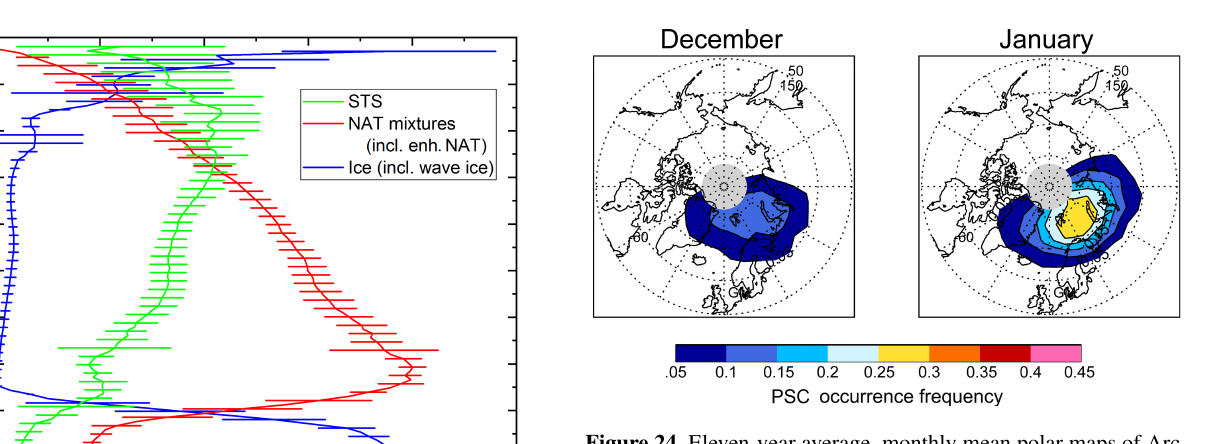
Figure 24. Eleven-year average, monthly mean polar maps of Arc- tic PSC occurrence frequency at θ = 500K ( ∼ 20km). Light gray regions indicate latitudes not sampled by